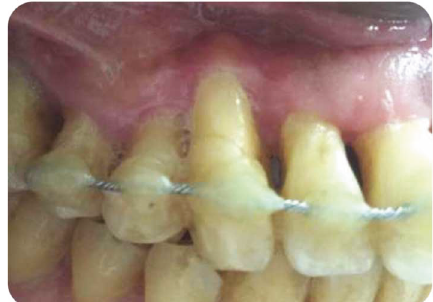
Figure 10: Soft tissue healing and periodontal splinting.